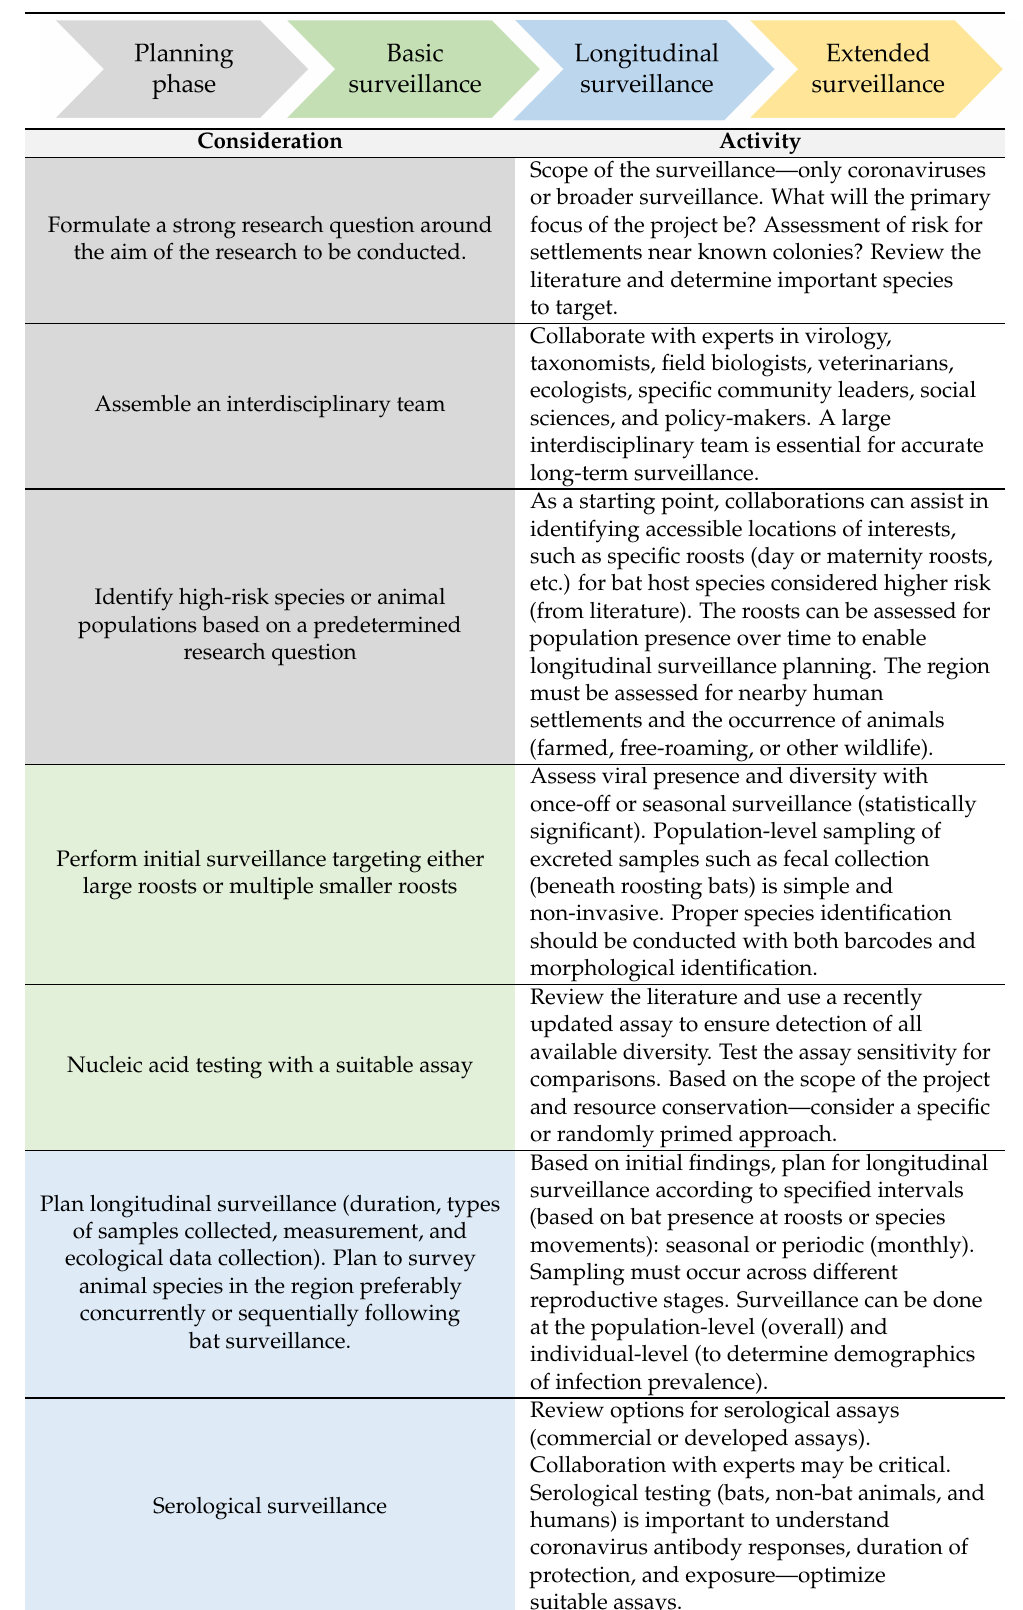
Table 5. Framework for activity planning when implementing coronavirus surveillance in bat populations, other wildlife species, domesticated animals, and impacted human